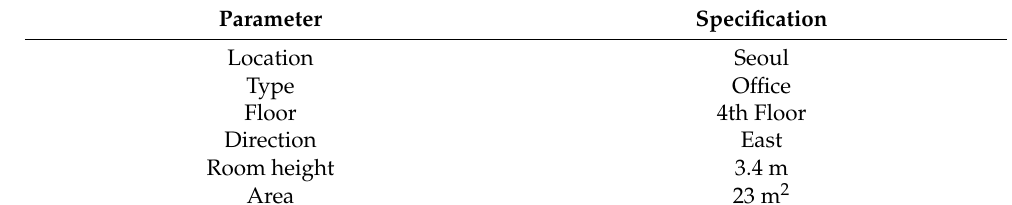
Table 3. Experimental outline.